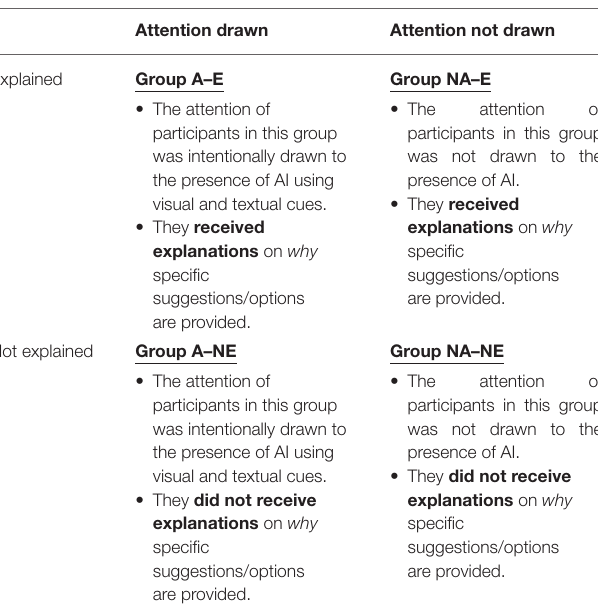
TABLE 2 | Overview of participant